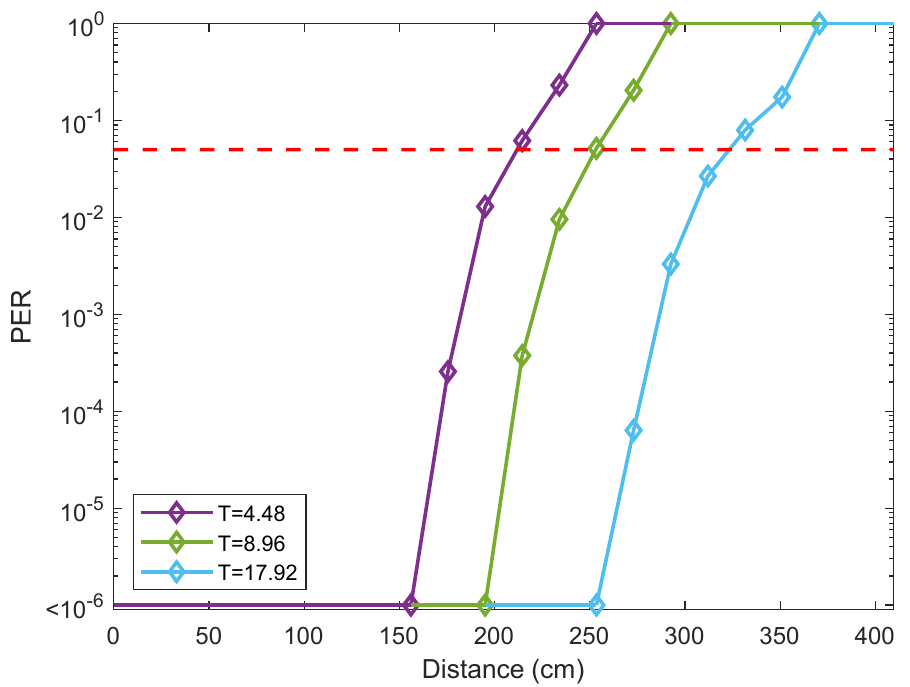
Figure 11. PER measured at different communication distances with the 3 chirps of T = 4.48 (violet), T = 8.96 (green), T = 17.92 (light blue). Blue marks represent the measurement points.